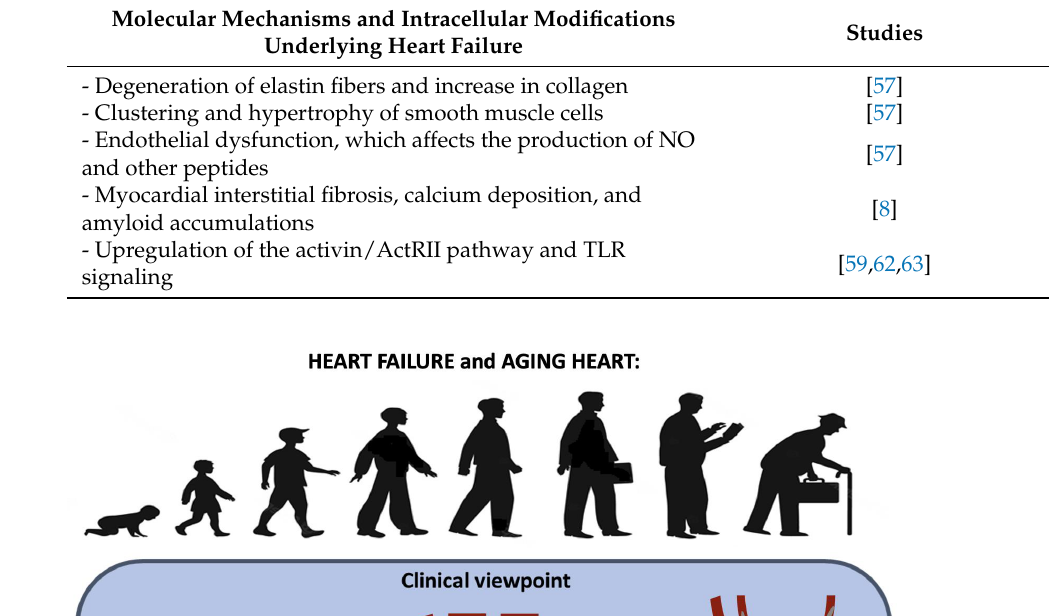
Table 2. Molecular mechanisms and intracellular modifications underlying heart failure (HF).